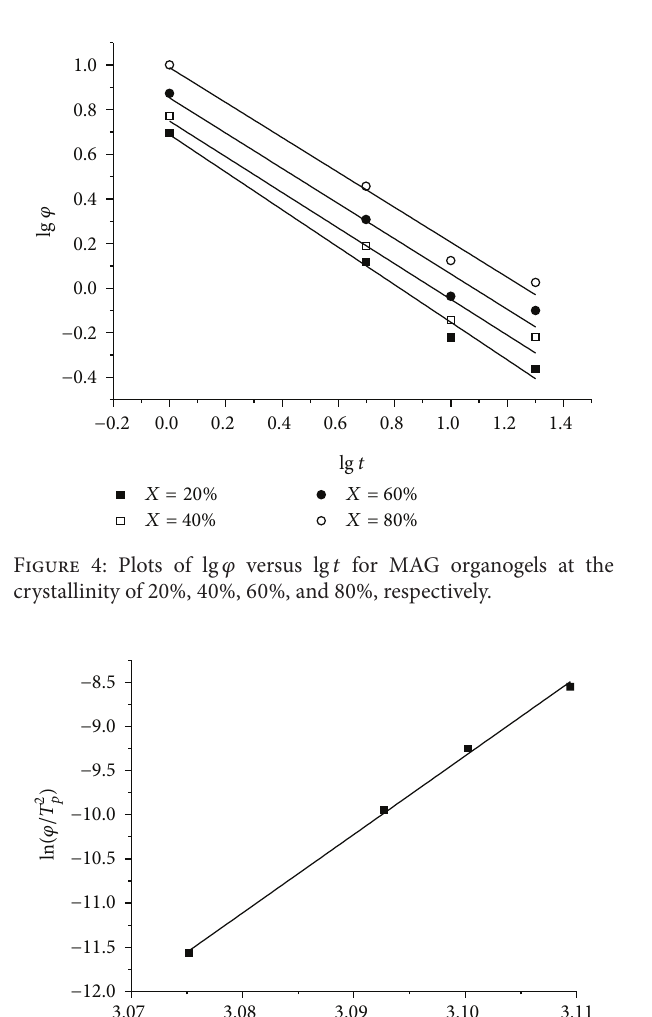
crystallization behavior. The parameter 𝑎 shows only a small decrease with the increasing relative degree of crystallinity, ranging from 0.841 to 0.783, indicating that the ratio of 𝑛 to 𝑚 almost remained constant at different